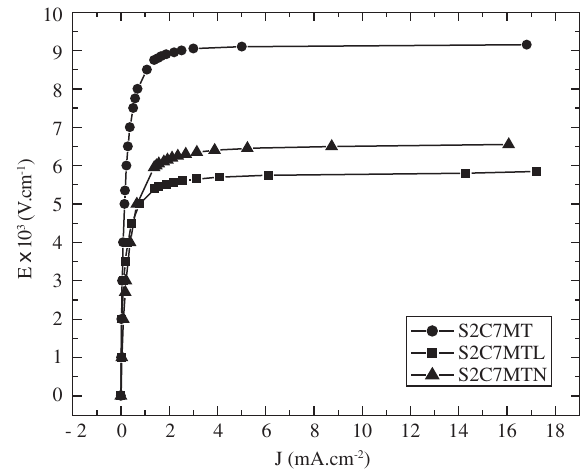
Figure 2. Electric field vs. current density curves ( V-I characteristics) behavior of